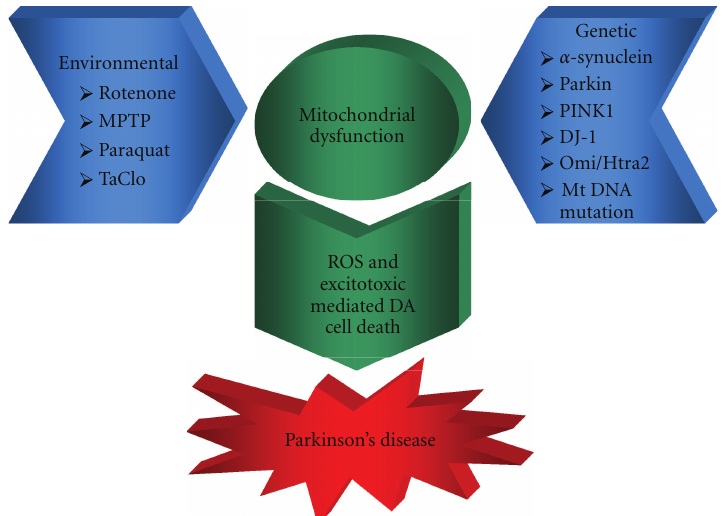
Figure 5: Schematic representation of mitochondrial dysfunction in Parkinson’s disease: environmental and genetic factors combine to cause mitochondrial dysfunction leading to ROS- and excitotoxic mediated DA cell death and Parkinson’s